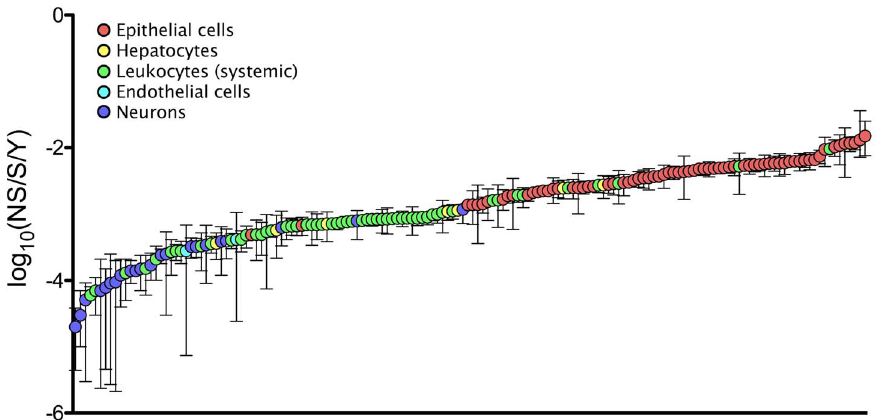
Figure 4. Nucleotide substitution rates and principle target cells of mammalian RNA viruses. Log scale mean nucleotide substitution rates (log 10 (nucleotide substitutions per site per year, NS/S/Y)) of all RNA viruses included in this study with 95% credibility intervals. Credibility intervals that are not visible are eclipsed by the symbol or, in three cases (NoV GII.b, HEV, and TBEV), were not available from the published source. Sources of the rates are given in Table S1.